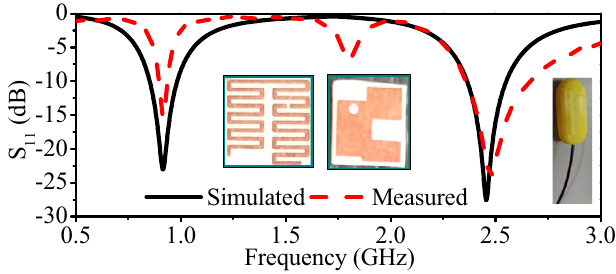
Figure 11. Simulated and measured reflection coefficient of the implantable antenna.